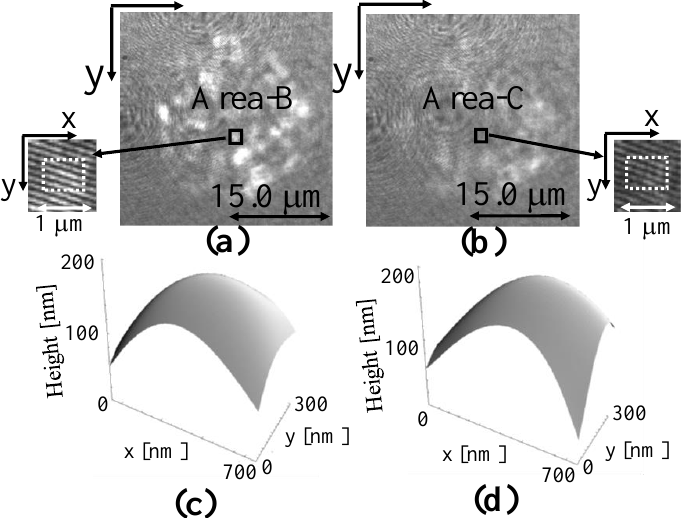
Figure 9. Measured 3D shape of 700 nm sphere at the same position: ( a ) Speckle pattern without aperture (diffraction limit: 523 nm); ( b ) Speckle pattern with aperture(diffraction limit: 1119 nm); ( c ) Phase map of measured 3D shape without aperture in Area-B; ( d ) Phase map of measured 3D shape with aperture in